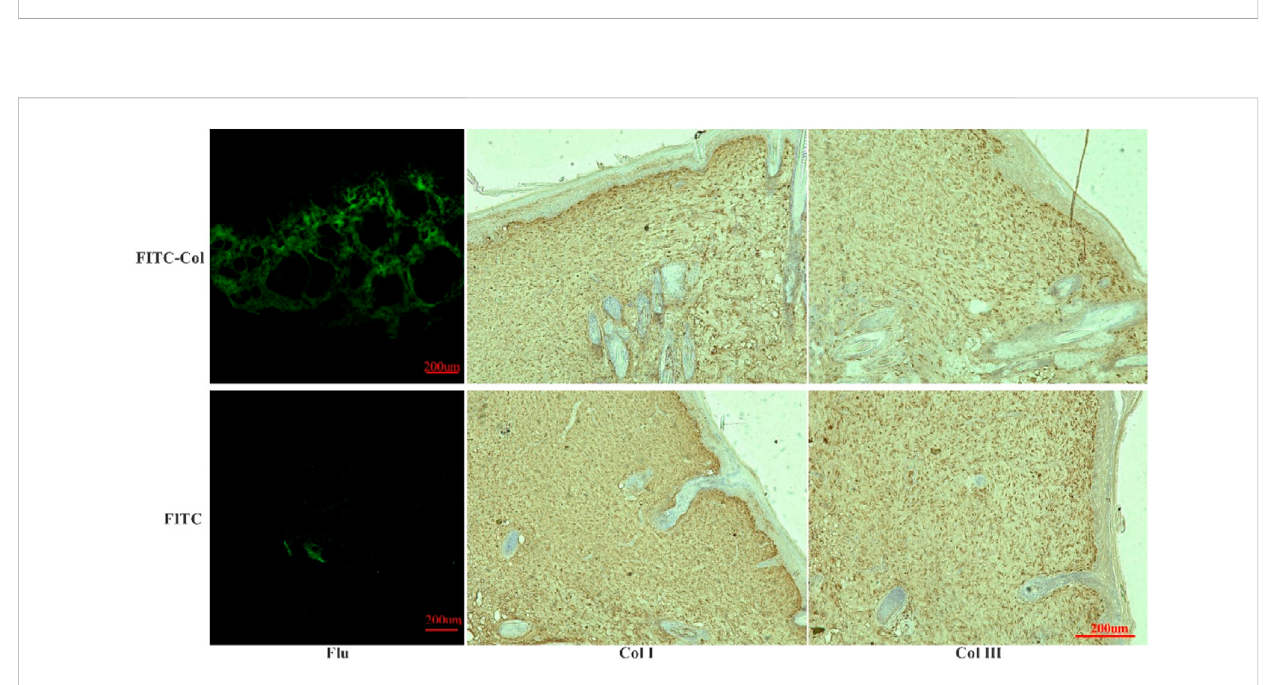
FIGURE 9 Fluorescence observation in frozen sections and immunohistochemical analysis of Col I and Col III. (FITC-Col: FITC-labeled fi sh collagen; FITC: FITC fl uorescein; Flu: Fluorescence observation results of frozen sections; Col I: Immunohistochemical results of Col I; Col III: Immunohistochemical results of Col